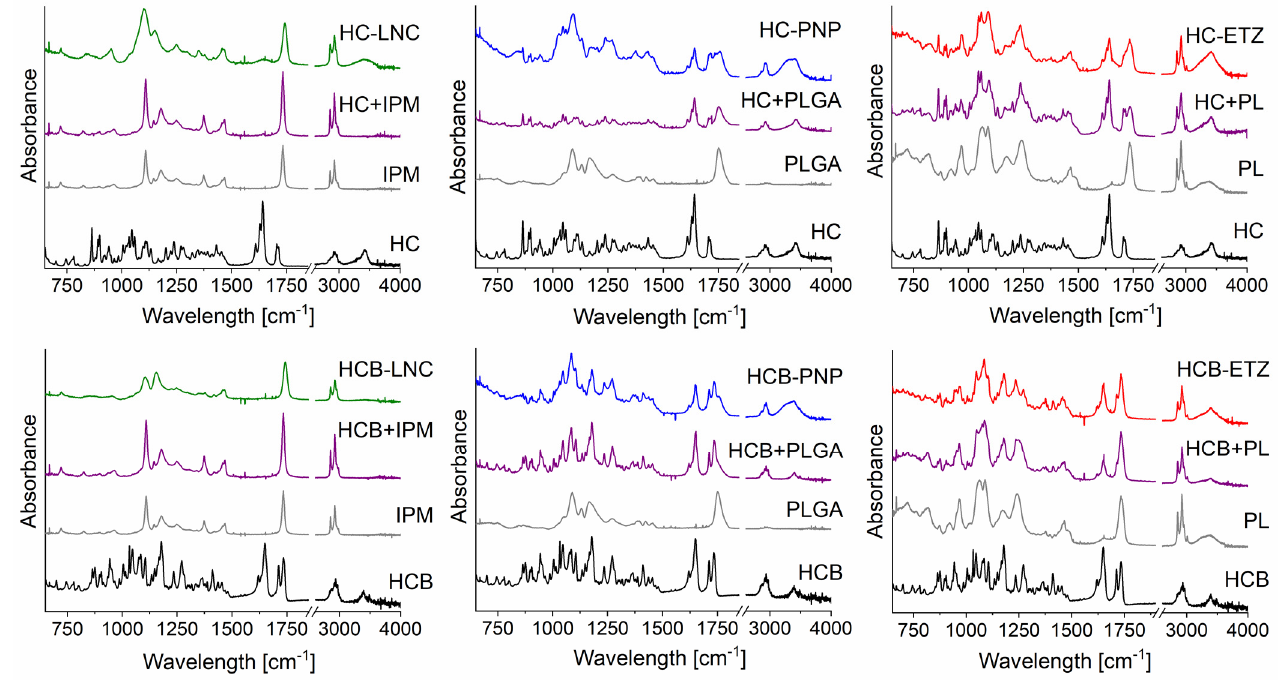
Figure 2. FTIR spectra of pure API-black (named HC; HCB), physical mixture of API with individual components of the nanoformulations—purple: isopropyl myristate (named HC/HCB + IPM), poly(lactic-co-glycolic acid) (named HC/HCB + PLGA) and Phospholipon 90G (named HC/HCB + PL); and of the freeze-dried API nanoformulation: green—lipid nanocapsules (HC/HCB-LNC), blue—polymeric nanoparticles (HC/HCB-PNP), red—ethosomes (HC/HCB-ETZ).